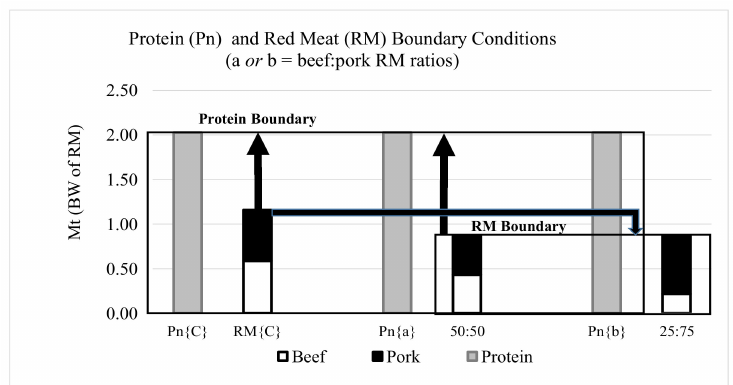
Figure 1. Schematic diagram of the boundary conditions applied to beef, pork and broiler consump- tion (C) expressed as boneless weight (BW) of RM, in the livestock production scenarios used to assess the carbon footprints of the Canadian livestock